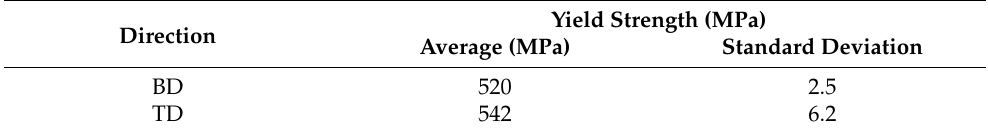
Figure 5. Room temperature engineering stress-strain curves obtained from the quasi-static compression tests in ( a ) building direction and ( b ) transverse direction. Table 2. Quasi-static compression test results of each direction.